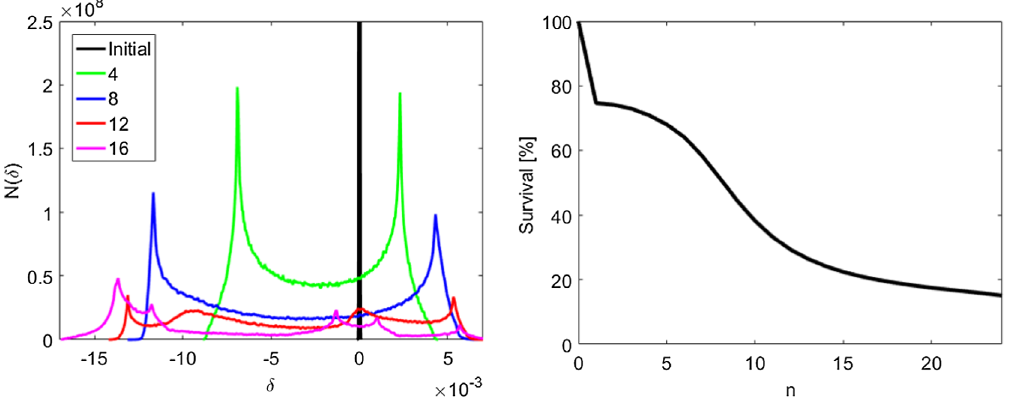
FIG. 13. Energy spectra and particle survival rate for the unbunched